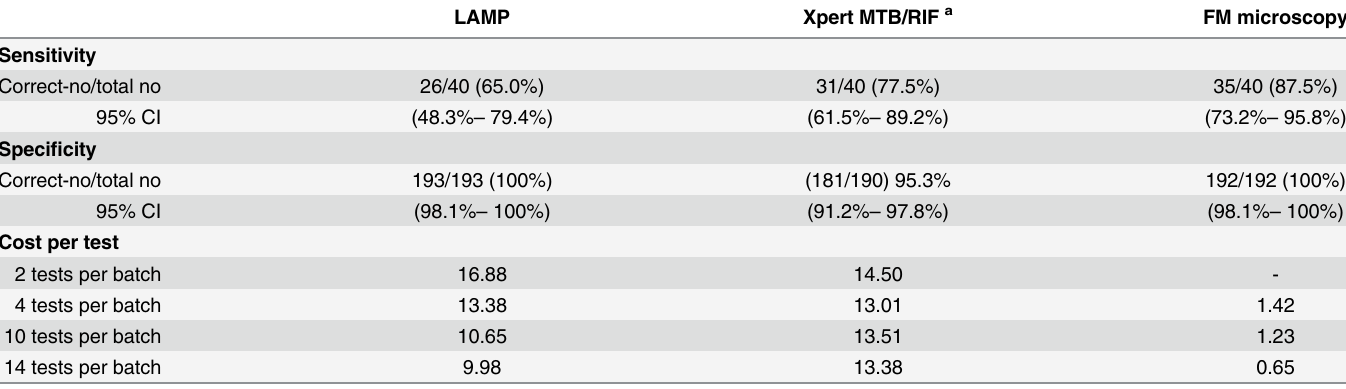
Table 3. Diagnostic accuracy of LAMP, Xpert 1 MTB/RIF and fluorescence smear microscopy and cost per test at different batch sizes (n =